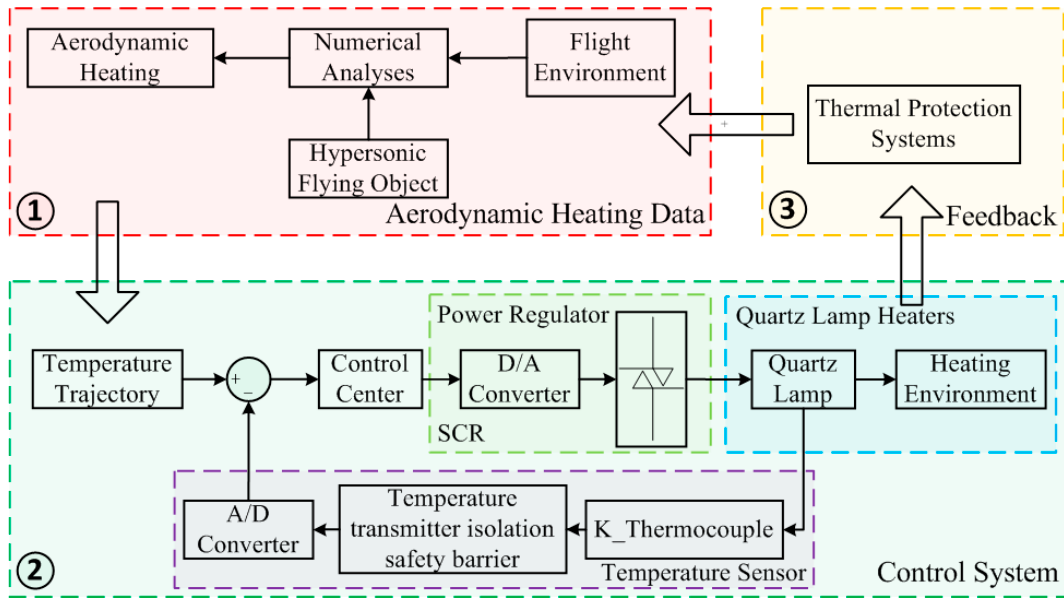
Figure 1. The flowchart of TSTQLs system.